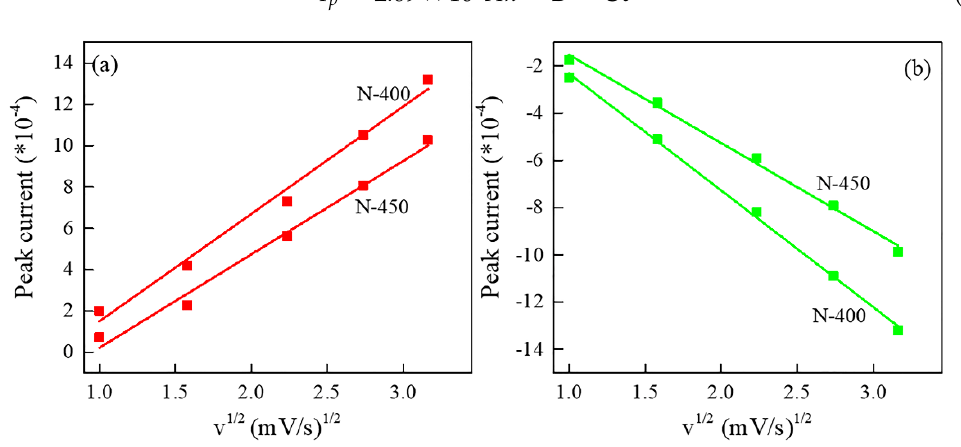
Figure 6. The linear fitting of the I p versus υ 1/2 relationships for the anode ( a ) and cathode ( b ) electrodes. In this equation, I p is the peak current (A); A is the effective area of the prepared V 6 O